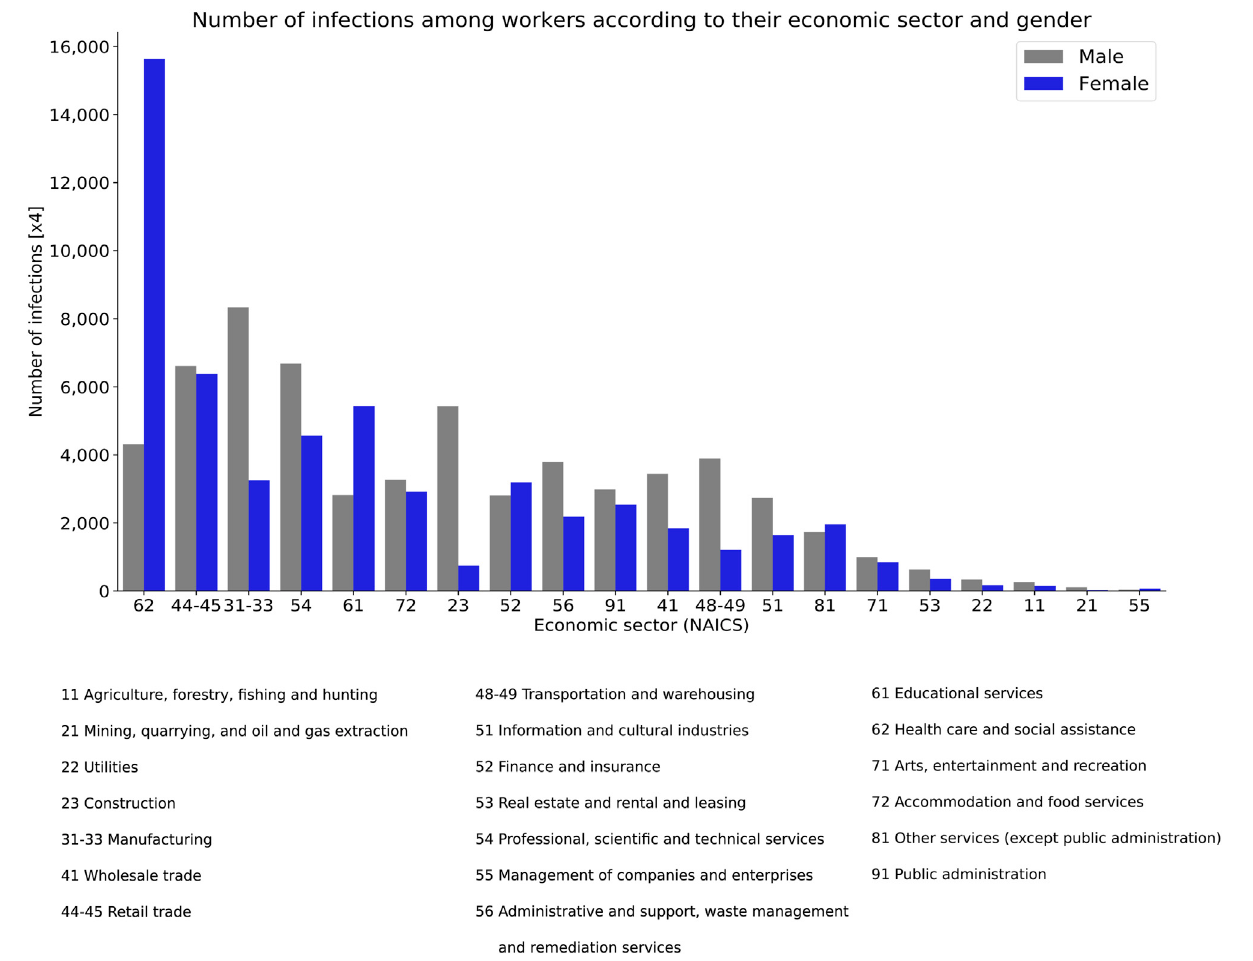
FIGURE 7 | Total infections in the workplace by gender and NAICS classi fi cation (North American Industry Classi fi cation System).